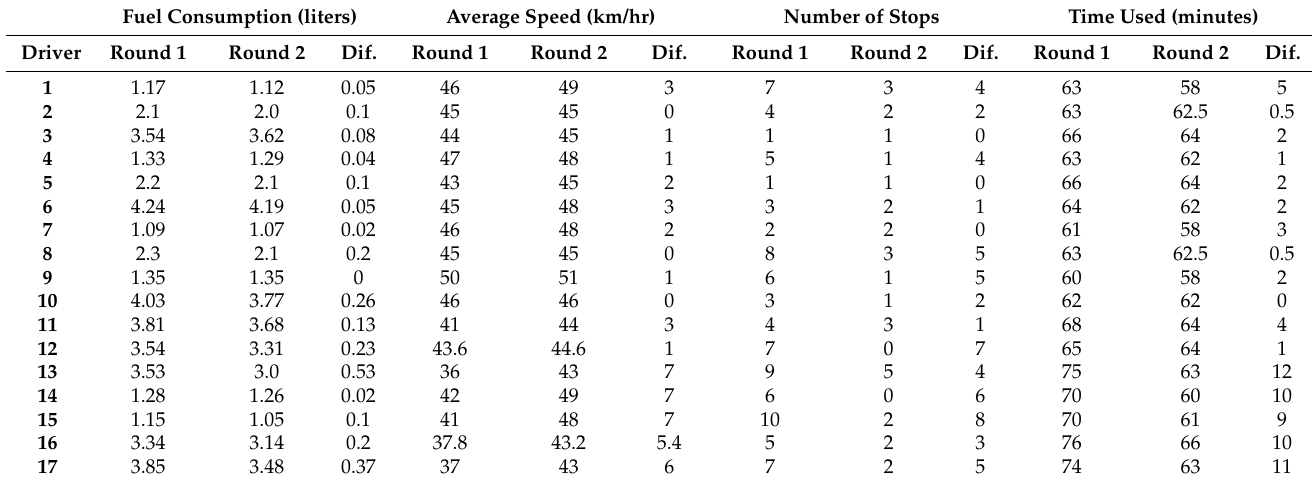
Table 7. Results for safe driving training module